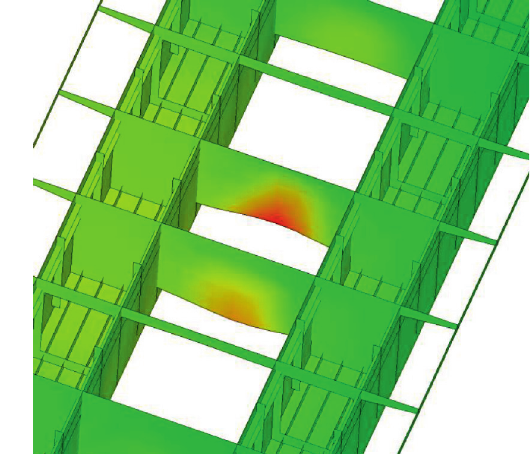
Figure 14: Failure model of girder (the roof is